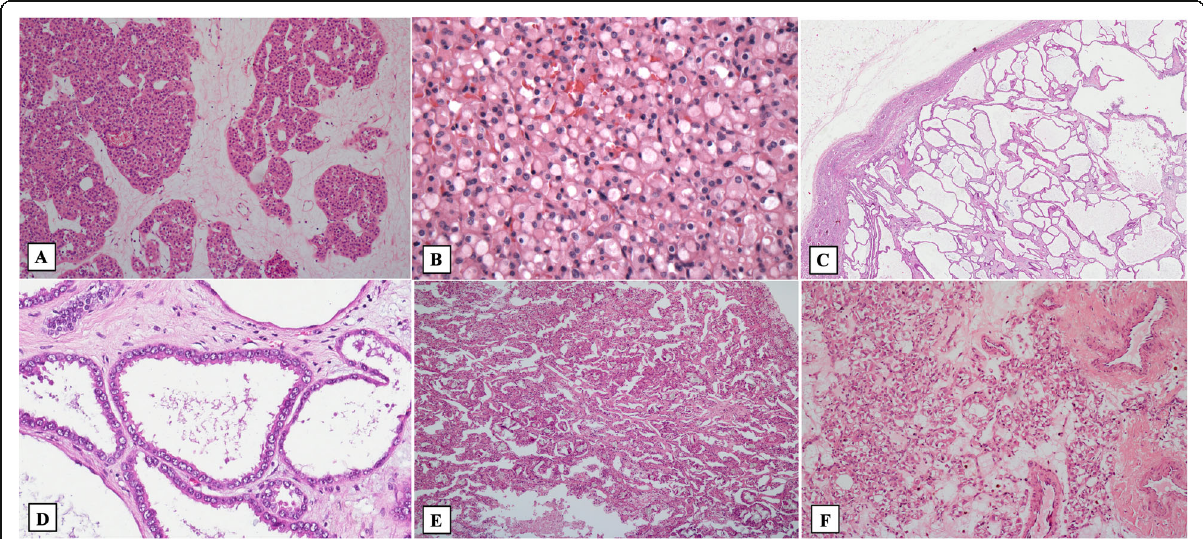
Fig. 5 Oncocytic renal tumors and some of their differential diagnoses. Oncocytoma – typical area of insular growth of oncocytic cells in a loose fibrous stroma ( a HE, 100x). Succinate dehydrogenase (SDH) deficient renal cell carcinoma shows diffuse solid growth of eosinophilic cells with and vacuolated cytoplasm or granular flocculent appearance ( b HE, 200x; courtesy of Dr. Kiril Trpkov, University of Calgary). Tubulocystic carcinoma is formed by small and medium sized tubules with occasional cystic dilated tubules. The tumor cells have eosinophilic/oncocytic cytoplasm and nuclei show a typical prominent nucleolus (HE: c 10x and d 100x). Acquired cystic disease associated renal cell carcinoma typically displays sieve-like morphology and microcystic architecture with oxalate crystals (e HE, 100x). Epithelioid angiomyolipoma may mimic epithelial tumors with clear and eosinophilic cells ( f HE,